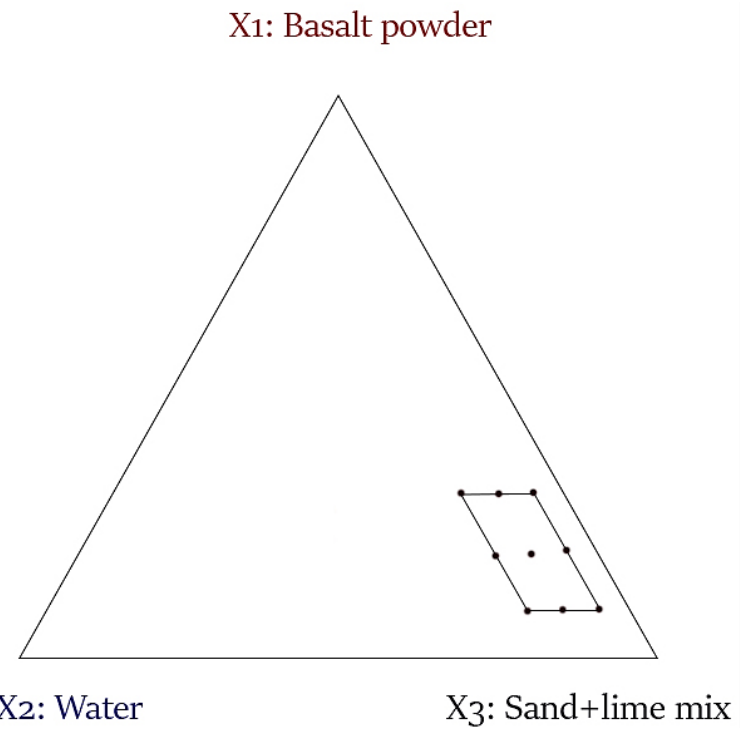
Figure 2. Model of a mixture experiment design with constraints for three independent variables.